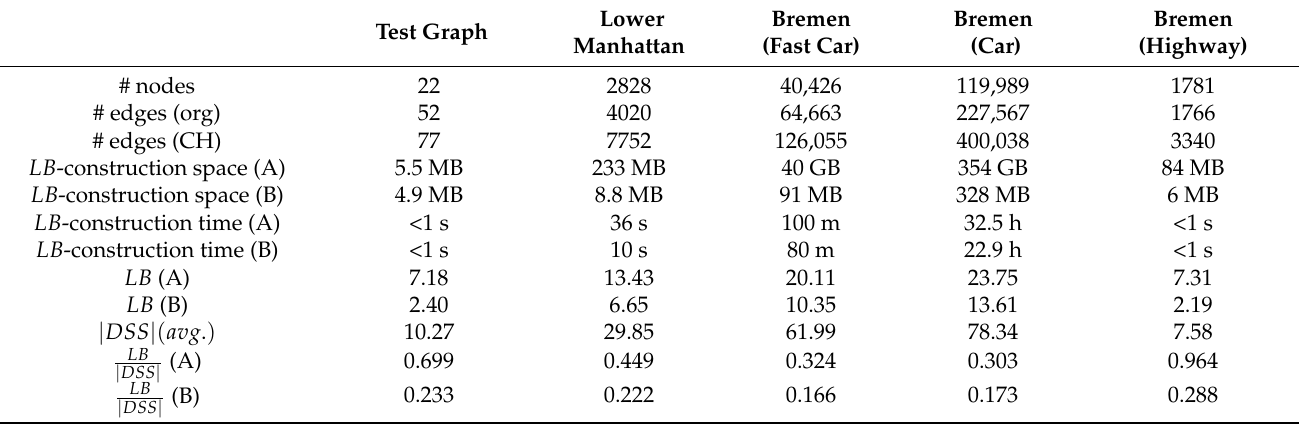
Table 1. Experimental results.